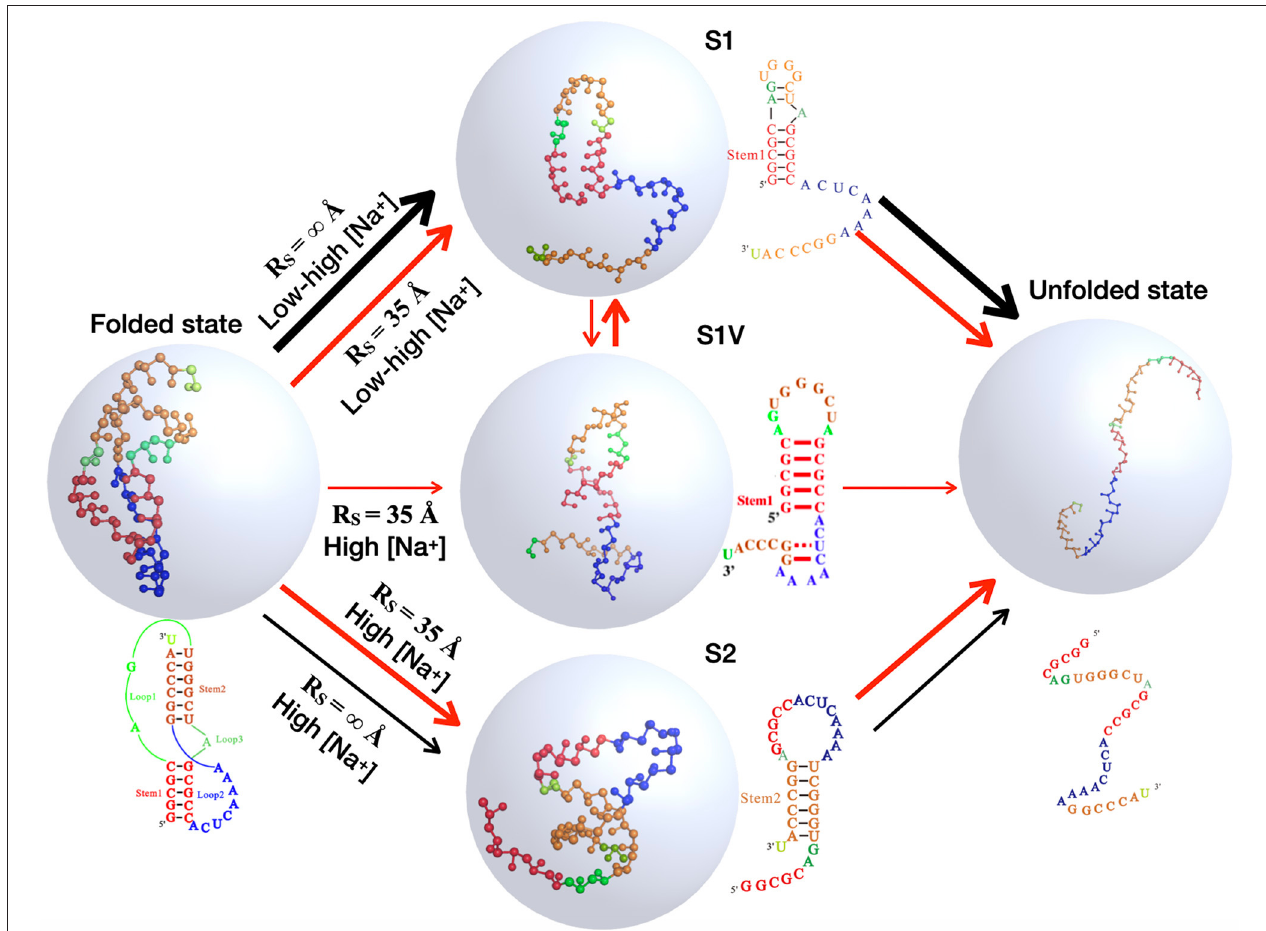
FIGURE 7 | The schematic diagrams show the structural transitions of the mouse mammary tumor virus (MMTV) pseudoknot in ion solutions along the unfolding pathway inferred from the respective fractions of states shown in Figure 6 , for the two typical cases: in the absence of spatial confinement ( R S = ∞ Å) and in the presence of strong spatial confinement ( R S = 35 Å). Ball-stick: the predicted 3D structures for different states shown with the PyMol